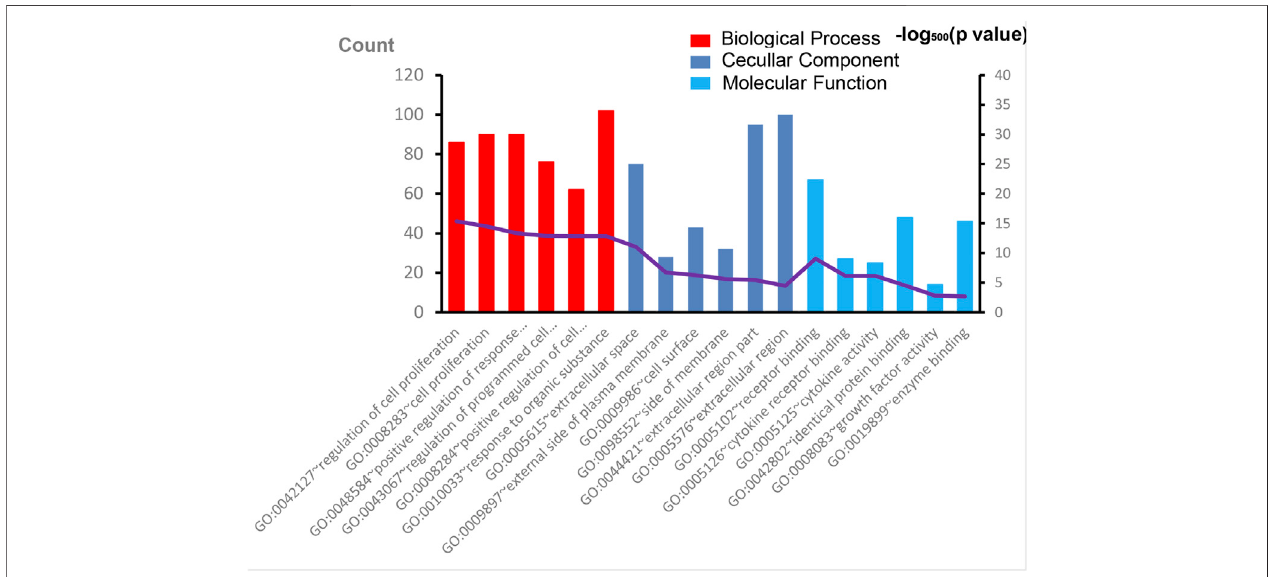
FIGURE 3 | The results of GO enrichment analysis. The top six signi fi cant enrichment terms of biological process, cellular component, and molecular function of overlapping genes are shown. GO, Gene Ontology.